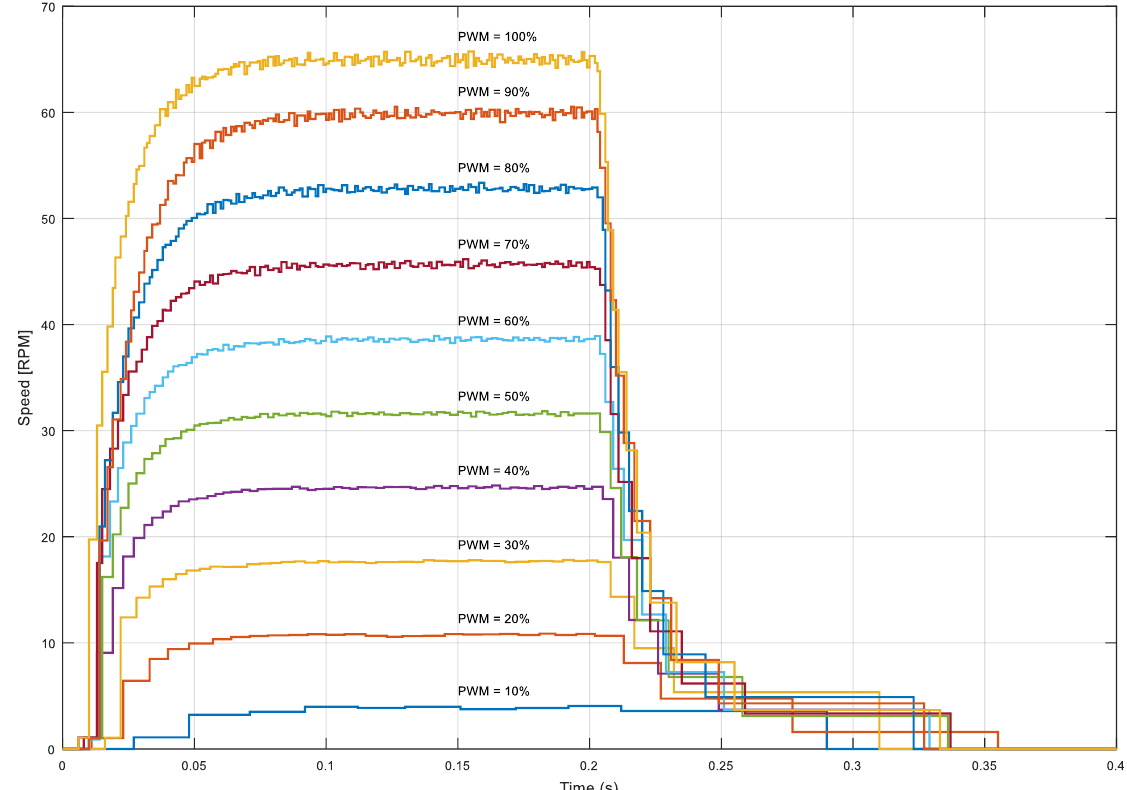
Figure 10. Motor step response for different PWM cycles.